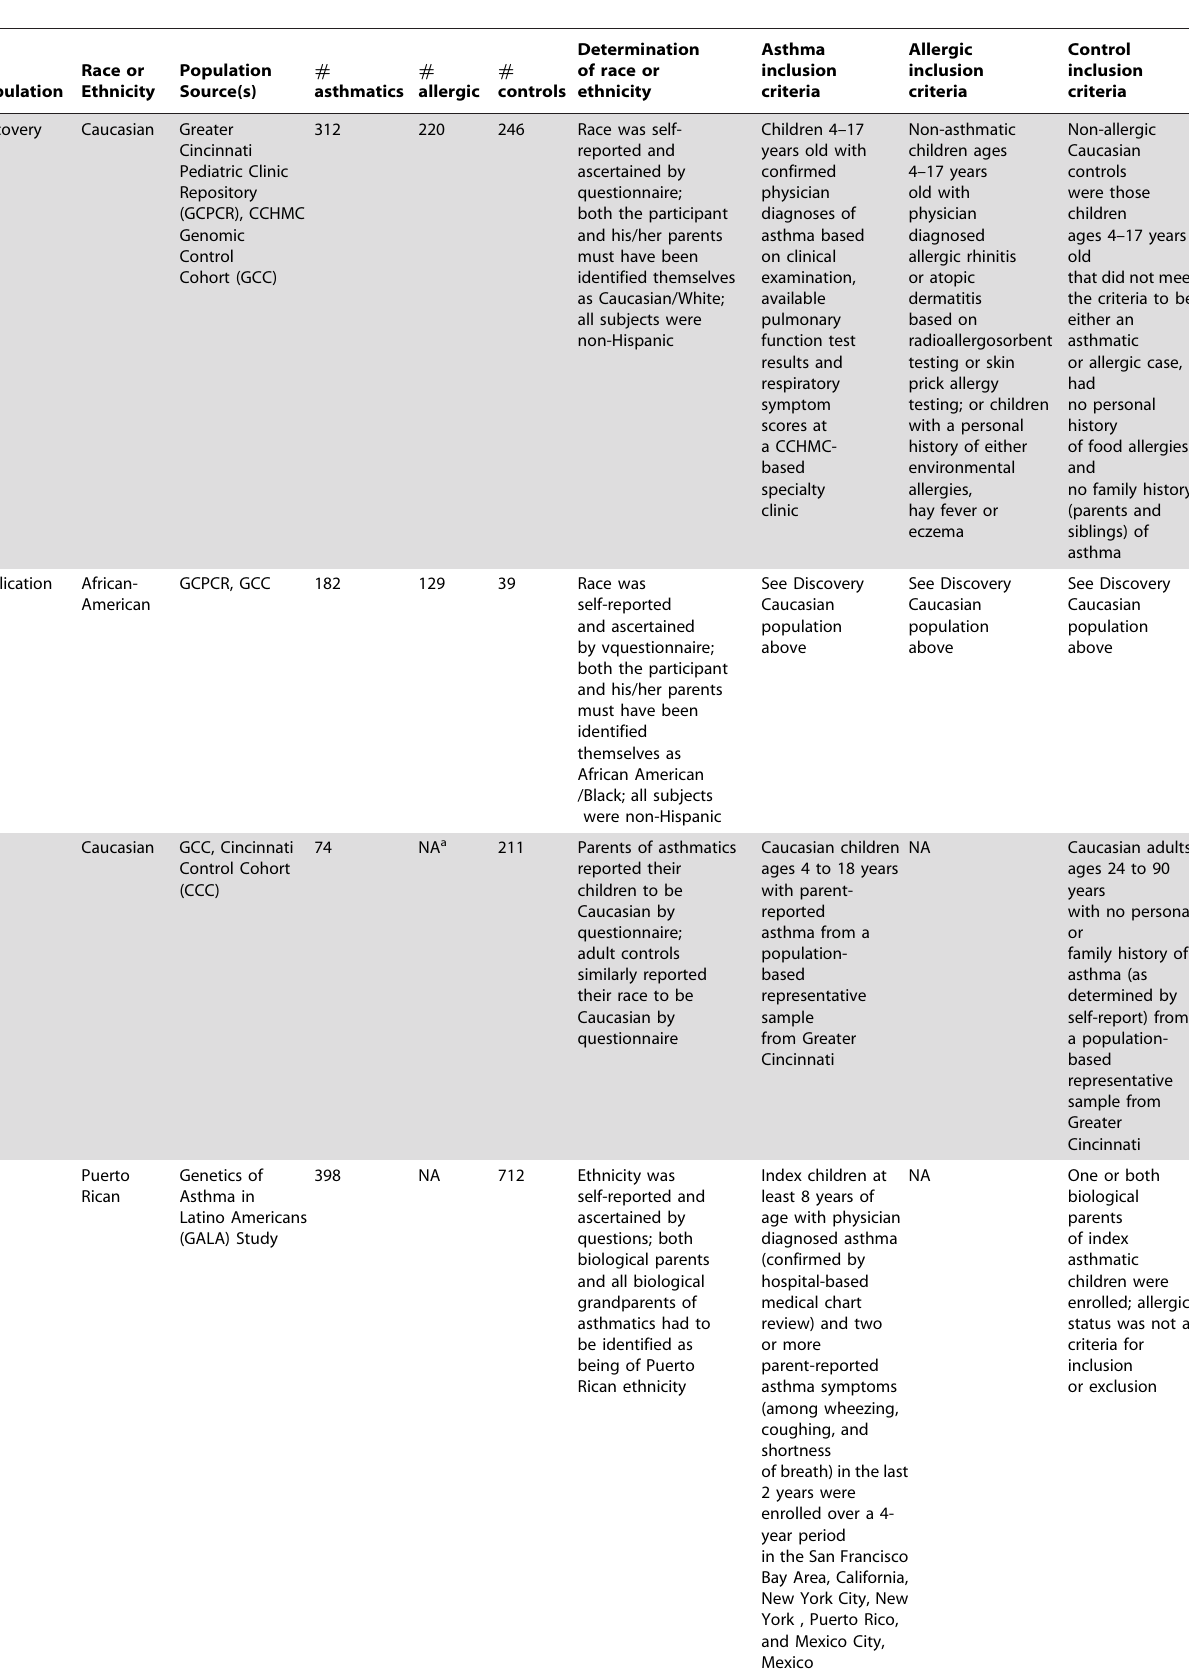
Table 2. Inclusion criteria of discovery and replication study populations.